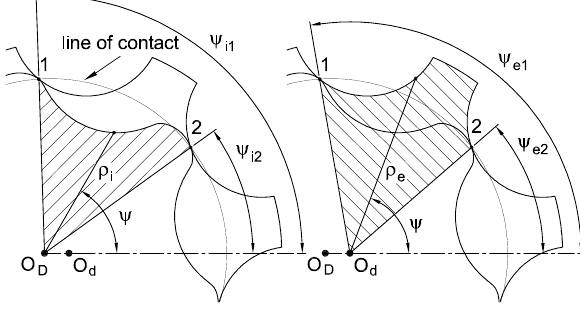
Figure 16. Method for the calculation of the area of a chamber in a gerotor pump.